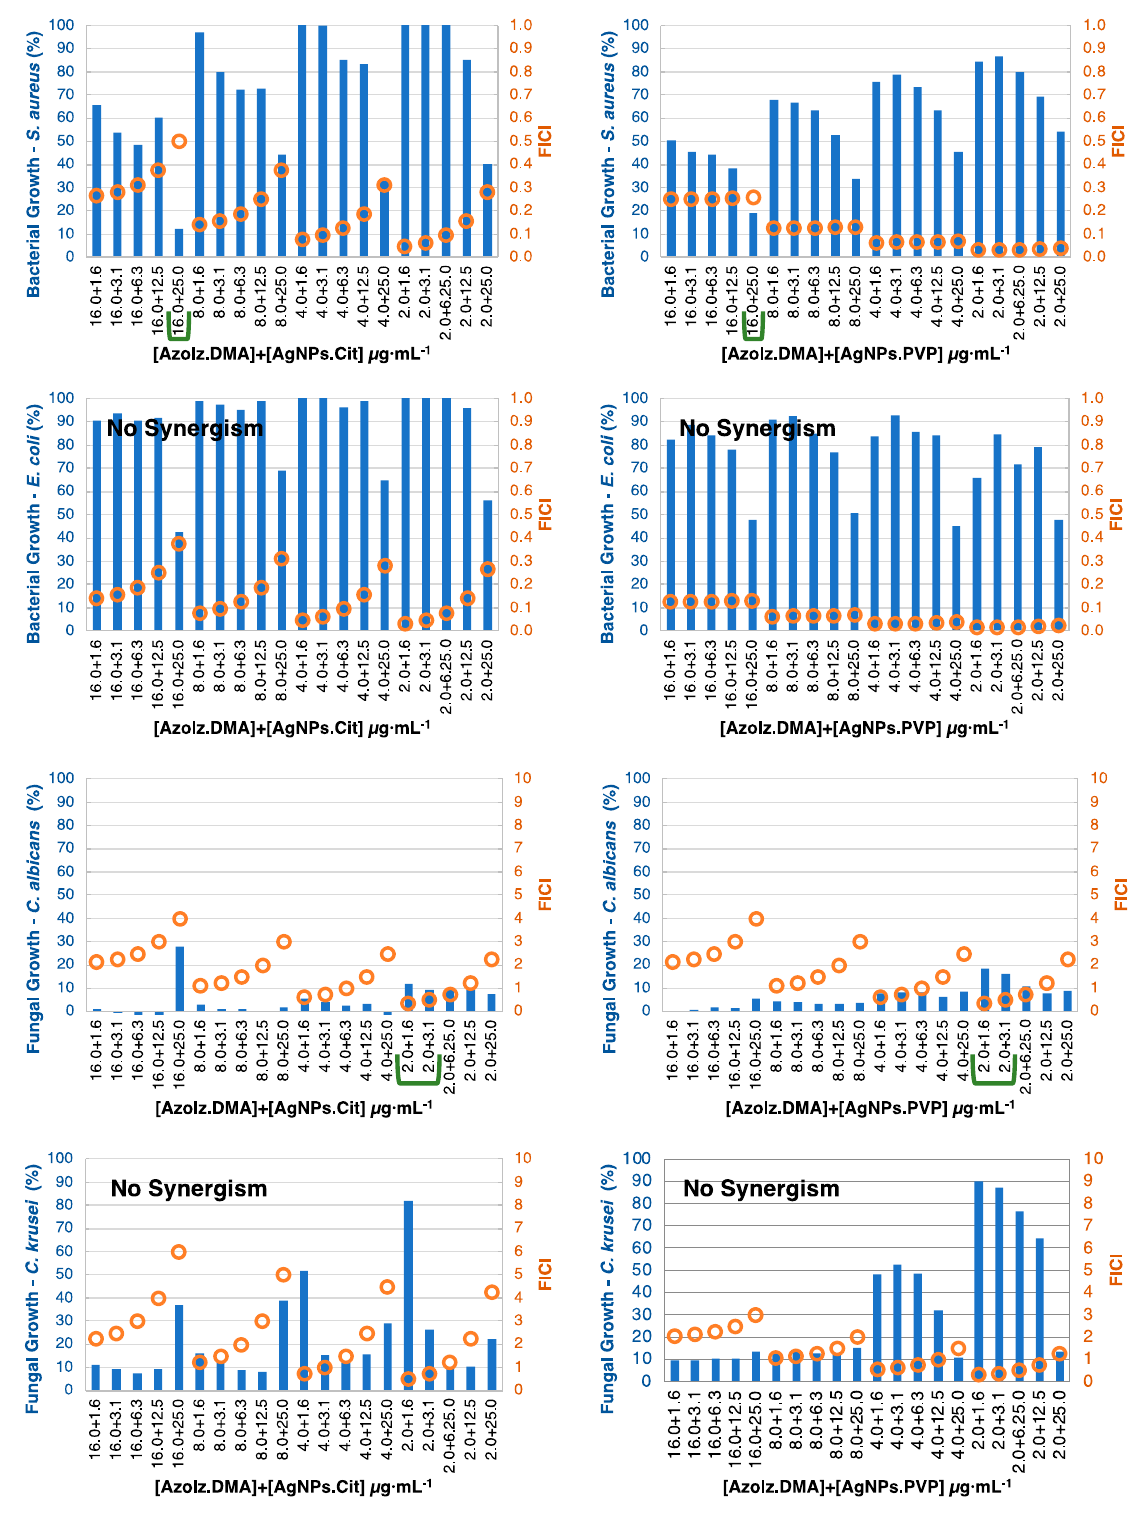
Figure 7. Checkerboard results by combining AzoIz.DMA (concentration ≤ 16.0 µ g · mL − 1 ) with AgNPs (concentration ≤ 25.0 µ g · mL − 1 ) showing positive synergistic results (green lines). Bars (blue) represent the microbial growth percentage, and dots (orange) represent the FICI values.